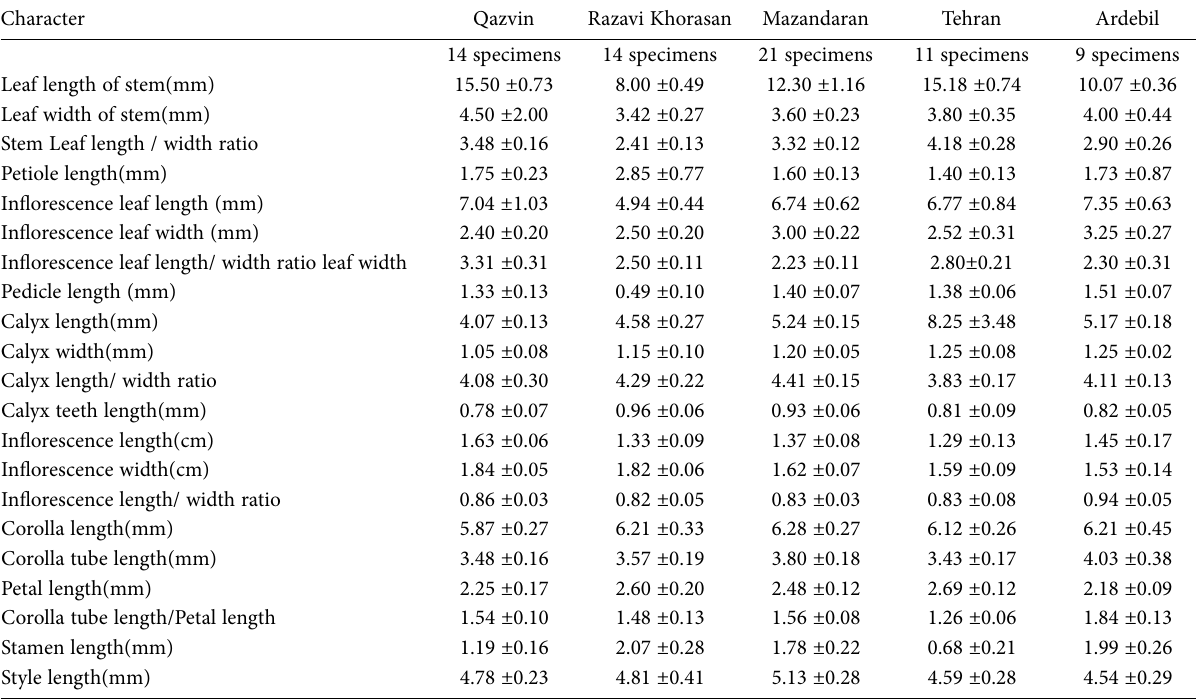
Table 4. The mean value and standard error of quantitative morphological characters.